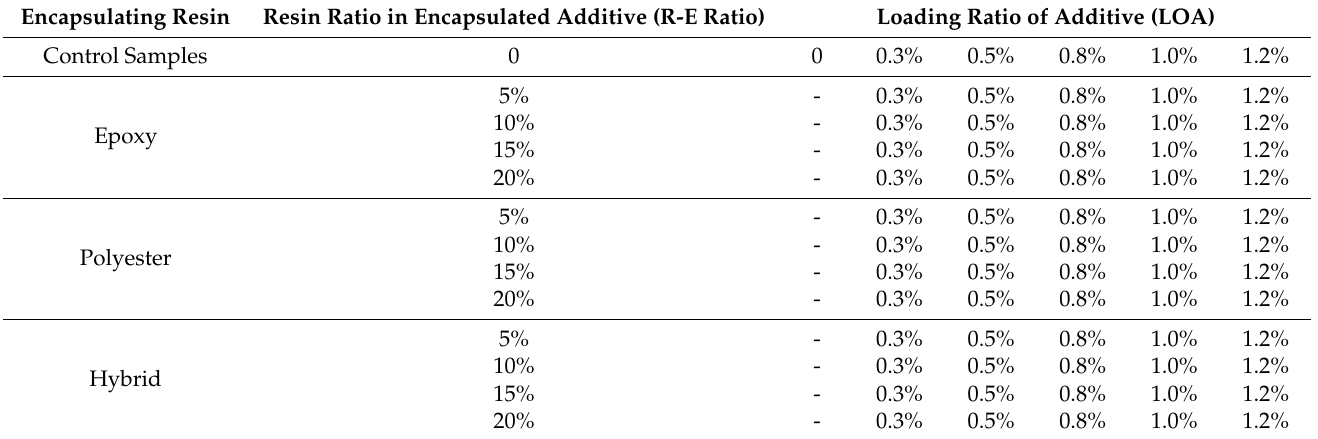
Table 3. List of 66 FPP samples.